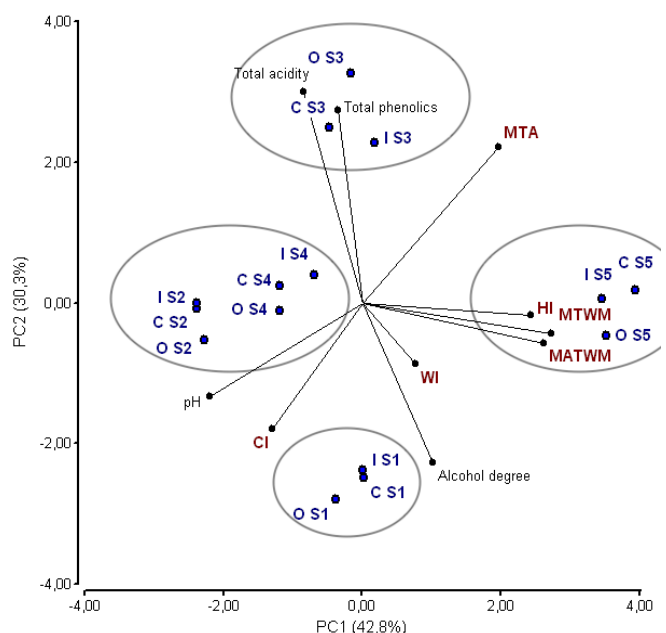
Figure 3. Principal component analysis (PCA) performed with wine oenological parameter obtained from Cabernet Sauvignon grapevines planted in an organic (O), integrated (I), and conventional (C) managements, together with different bioclimatic indices such as cool night index (CI), Huglin’s Heliothermal Index (HI), mean thermal amplitude (MTA), Winkler Index (WI), average mean temperature of the warmest month (MTWM), and maximum average temperature of the warmest month (MATWM) along five consecutive seasons (S).